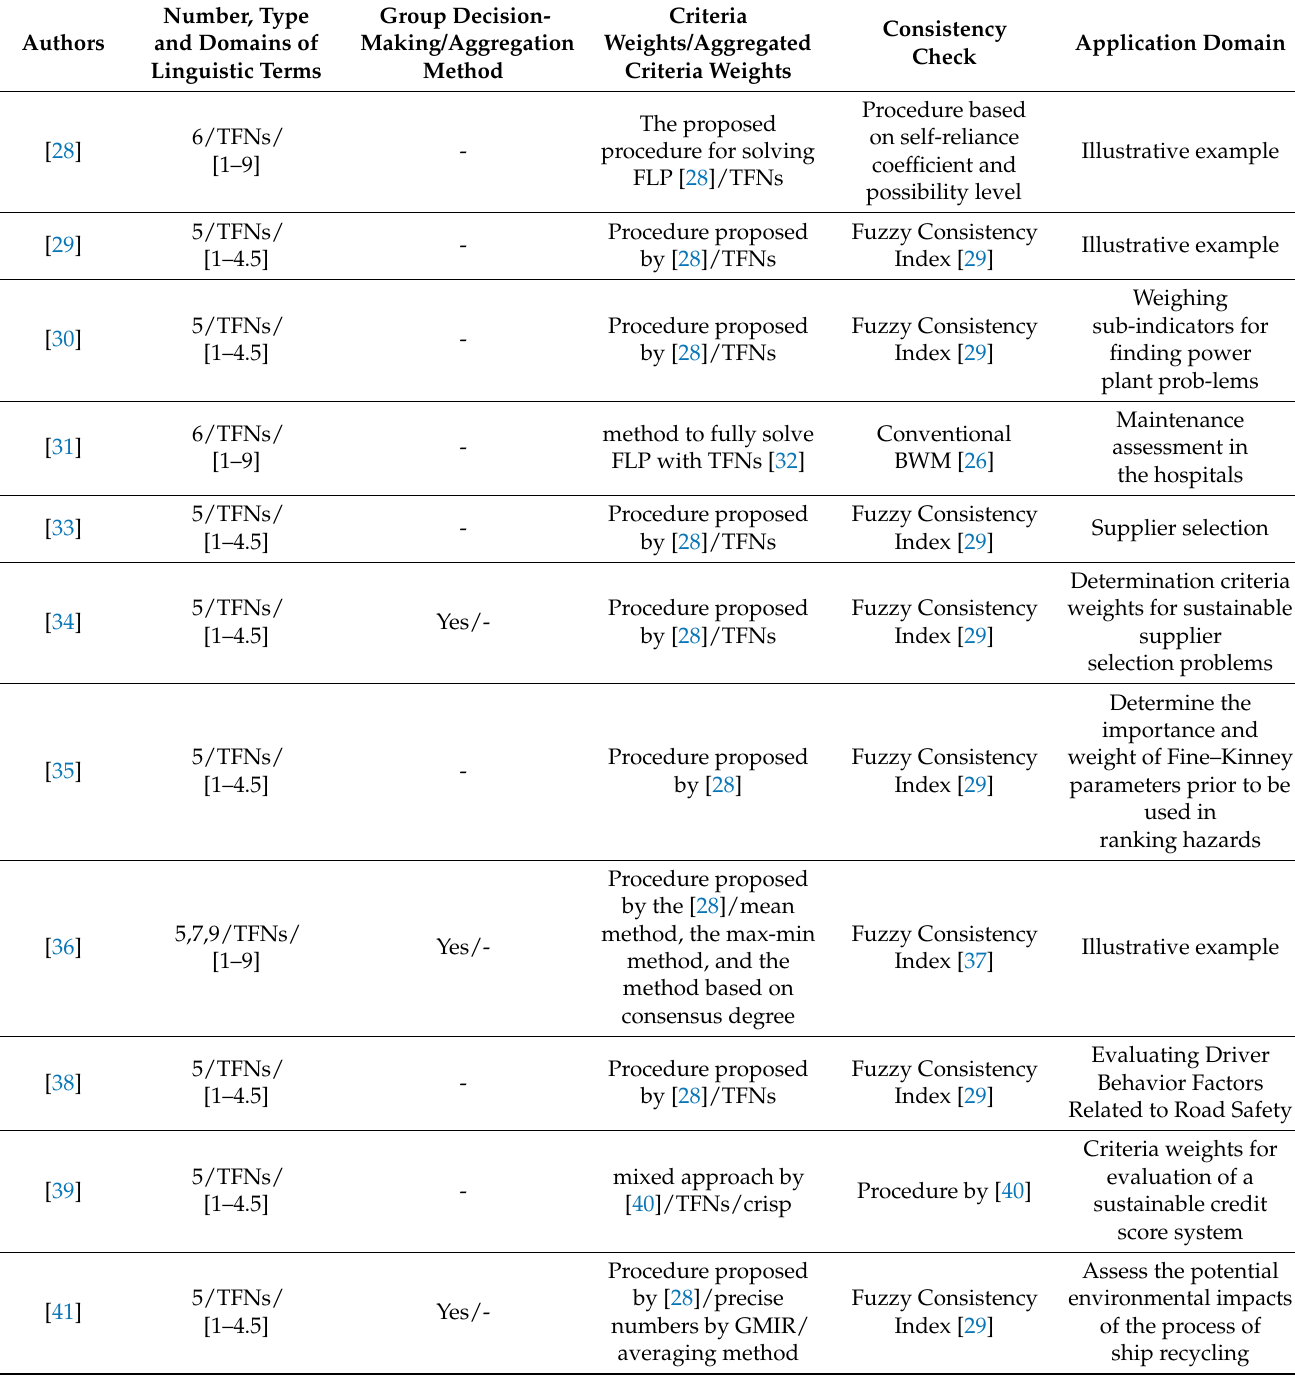
Table 2. Comparative analyses the proposed